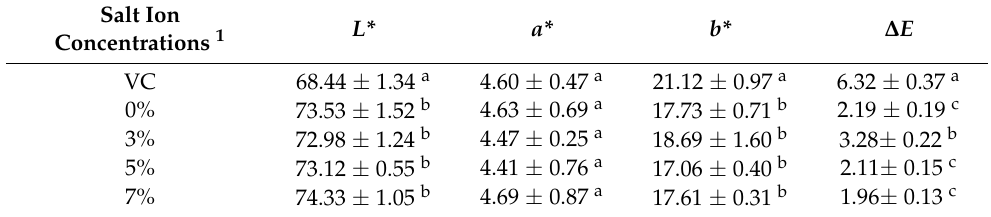
Table 2. Effects of immersion solutions with different salt ion concentrations on drumstick